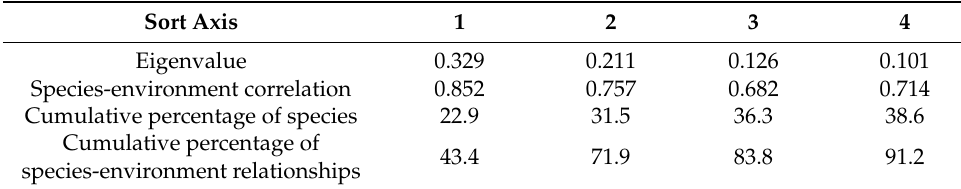
Table 3. Results of RDA analysis of dominant phytoplankton species.